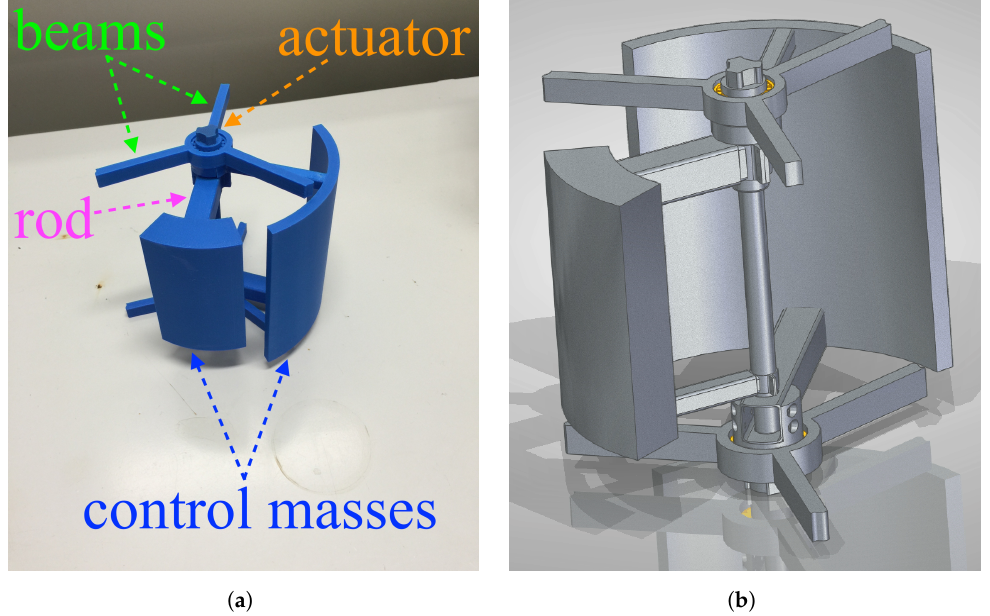
Figure 5. Design of the TRD for wind turbine towers: ( a ) View in maquette. ( b ) View in